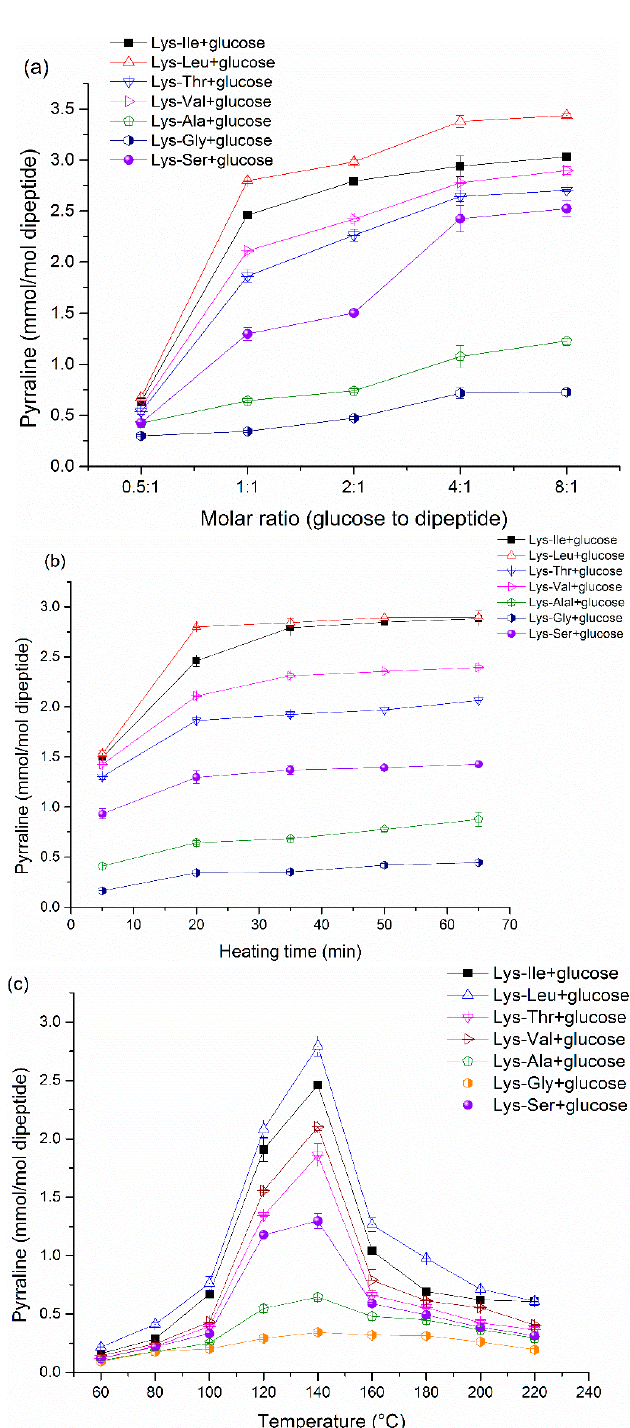
Figure 5. Peptide-bound pyrraline concentration in the heat-treated dipeptide-glucose mixtures, ( a ) dipeptide-glucose mixtures at different initial molar ratios, time 20 min, temperature 140 °C; ( b ) dipeptide-glucose mixtures at various heat-treated times, initial molar ratio 1:1, temperature 140 °C; ( c ) dipeptide-glucose mixtures at different heating temperatures, initial molar ratio 1:1, time 20 min.